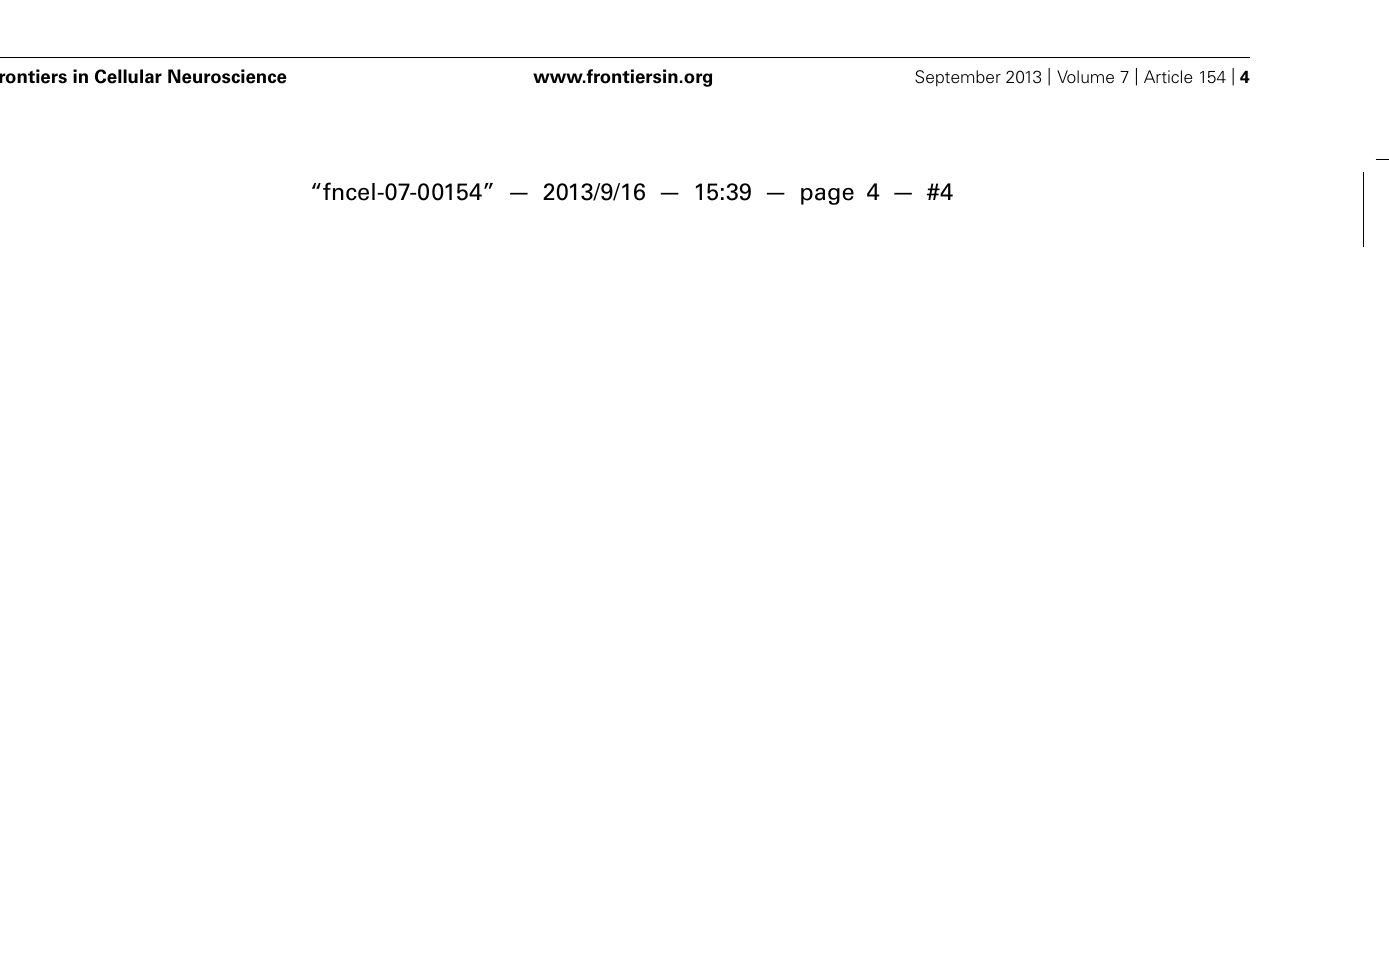
FIGURE 2 | Spontaneous electrographic seizures in partially deafferented cortex associated with increases in the maximal neural depolarization and hyperpolarization. Upper panel shows EEG and intracellular recordings from a neuron in area 5, 3 h after the undercut.Three fragments depicted by stars and arrowheads are expanded below. Horizontal dotted lines in middle